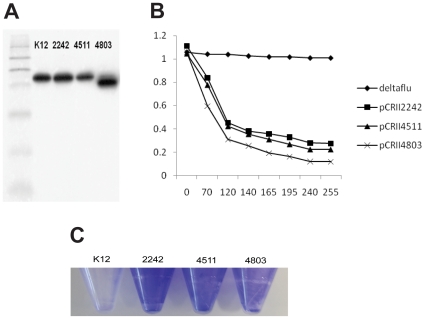
Functional characteristics of the EAEC 042 agn43 alleles.The three Antigen 43 encoding genes (Ec042-2242, Ec042-4511 and Ec042-4803) were cloned into a high copy number vector (pCRII-TOPO) and expressed in E. coli TOP10. (A) Western immunoblot of E. coli outer membrane fractions probed with anti-α43 antisera demonstrating all three alleles produced cross reacting species. As expected from nucleotide sequence analysis Ec042-4803 produces a smaller passenger domain than Ec042-2242, Ec042-4511 and Antigen 43 from E. coli K-12. Autoaggregation assays (B) and biofilm assays (C) of E. coli expressing each agn43 allele demonstrated that each gene product was capable of promoting autoaggregation or biofilm in a manner similar to that previously described. There was no appreciable difference between the proteins in their capacity to induce autotaggregation or biofilm formation. A strain lacking a functional agn43 allele (E. coli deltaflu) failed to autoaggregate and failed to form a biofilm.